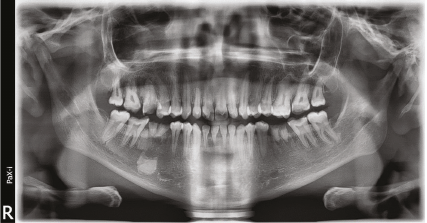
Figure 17: Case 3: dental panoramic tomography (DPT) shows taurodontism in